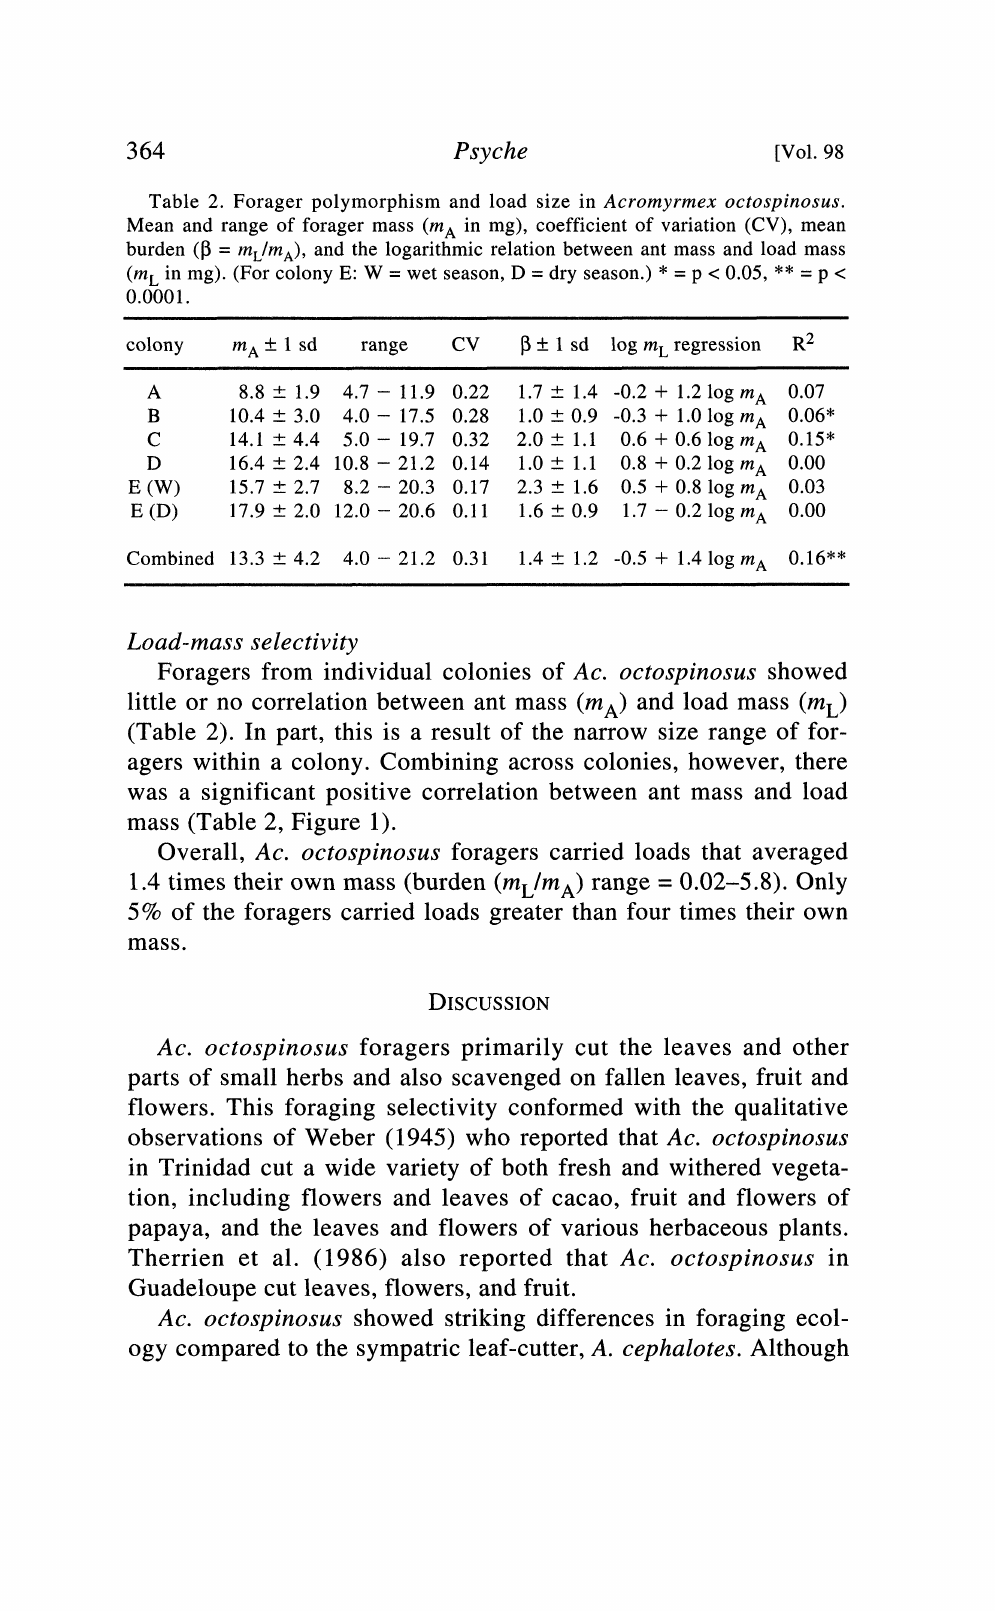
Table 2. Forager polymorphism and load size in Acromyrmex octospinosus. Mean and range of forager mass (m A in mg), coefficient of variation (CV), mean burden (I] mL/mA), and the logarithmic relation between ant mass and load mass (m E in mg). (For colony E: W wet season, D dry season.) * p < 0.05, ** p < 0.0001.